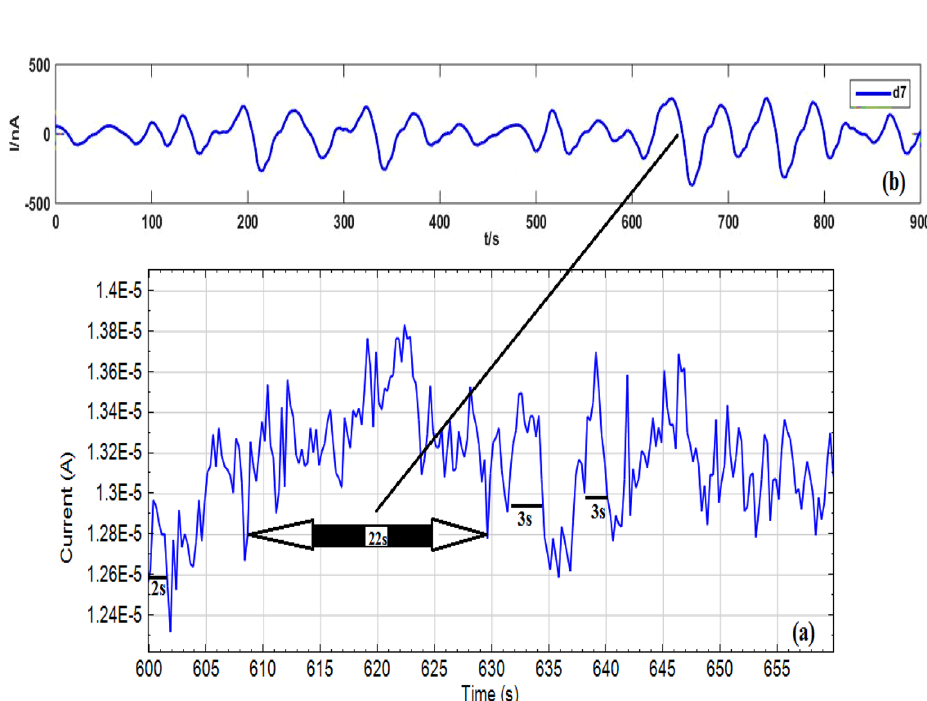
Figure 10. ( a ) The original signal of Sy-Co of RA/AgNPs 200 ppm concentration ( b ) the d7 partial